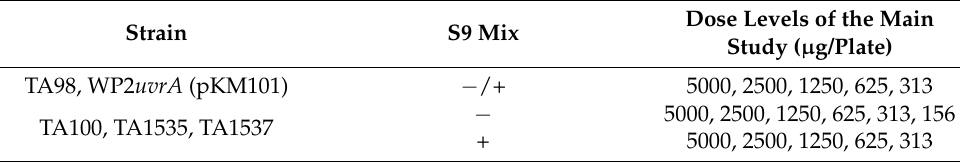
Table 1. Dose Levels of the Main